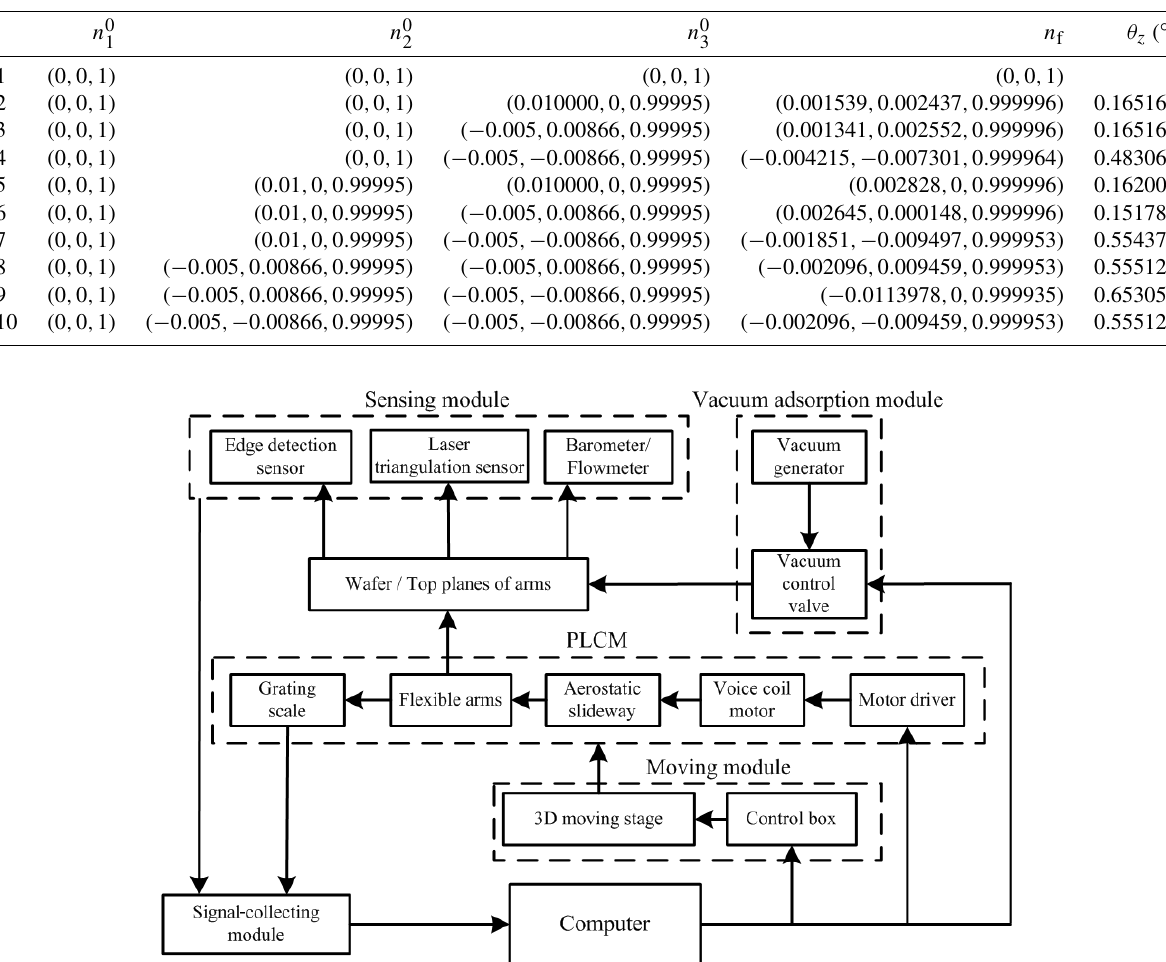
sor (KEYENCE) that has a 0.01 µm repeat accuracy and a ± 5 mm measurement range. The 3D moving stages are the xy axis moving stages and the R z rotary stage (BOCIC), which have a respective 0.1 µm and 1.4 µrad resolution and a respective 3 µm and 9.7 µrad positioning accuracy. Wafer edge detection selects a racer linear array charge-coupled de- vice (CCD) with a pixel size of 7 µm, an 8 bit output, and 1024 or 2048 units corresponding to a frequency of 18.35 or 9.42 kHz, respectively (BASLER). The position and ori- entation of the top planes were measured and fitted using the planar fit method without loading the carried object (Li et al.,